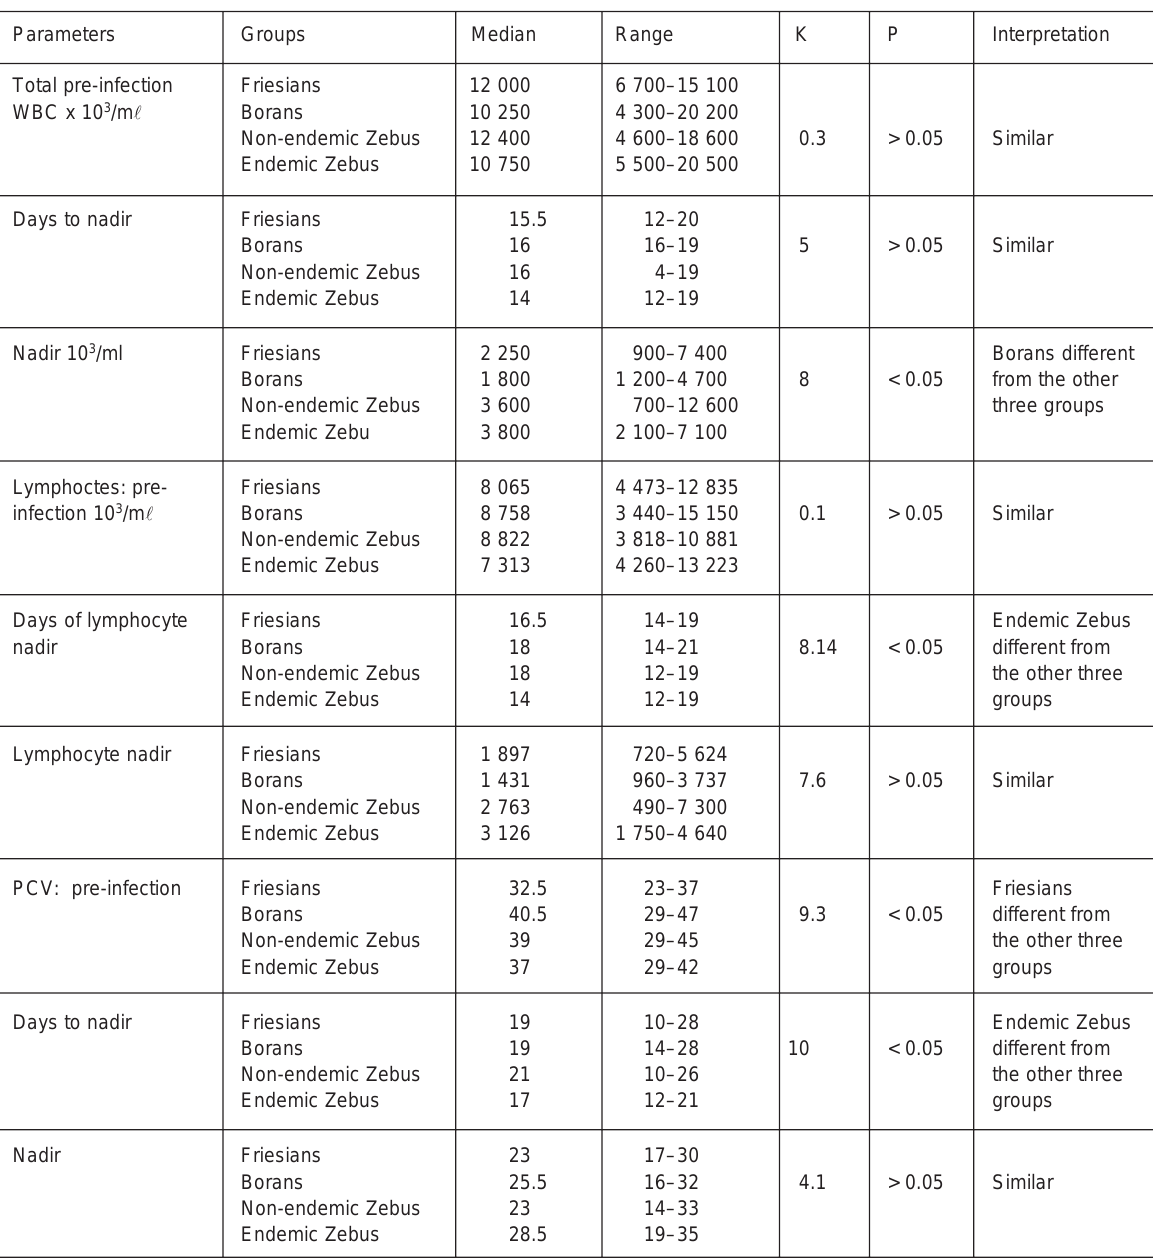
TABLE 3 Comparisons of haematological parameter